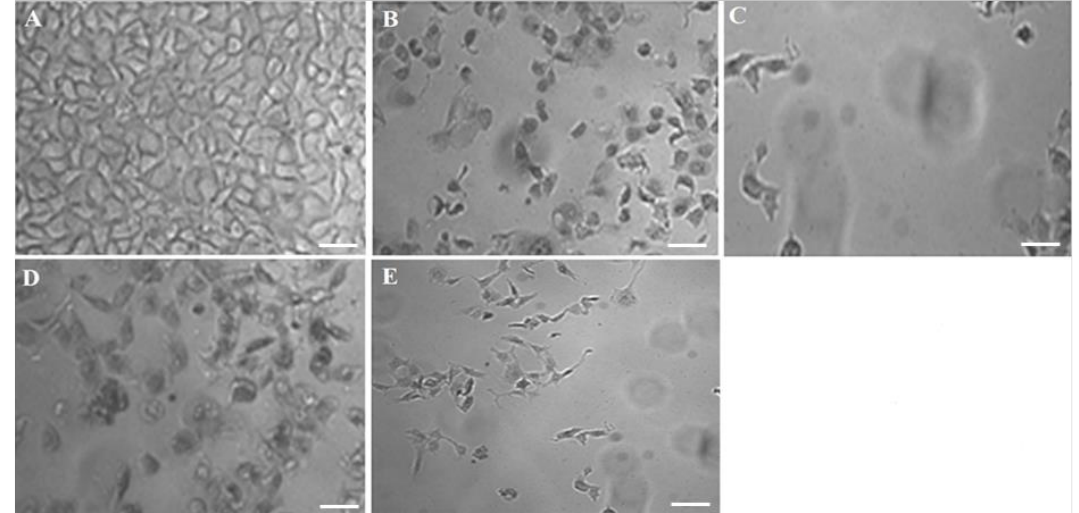
Figure 6. Concentration dependent in vitro antitumor activity (MCF-7) of the optimized formulation (F11) and 5-FU pure drug after 24 h of exposure: ( A ) Control group, ( B ) 0.5 × IC 50 of F11, ( C ) IC 50 of F11, ( D ) 0.5 × IC 50 of 5-FU pure and ( E ) IC 50 of 5-FU pure. Scale bars = 50 µm.